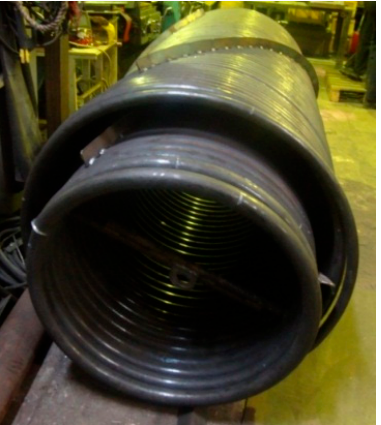
Figure 5. Coaxial cylinders consisting of spiral coils.